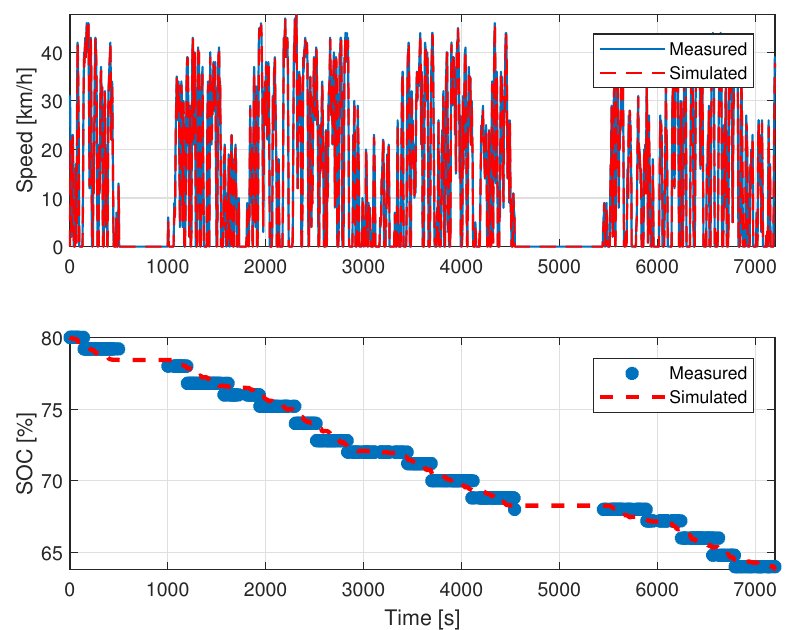
Figure 4. Comparison of the the baseline electric bus (EB) model’s state of charge (SOC) against experimental measurements for an in-service drive cycle.